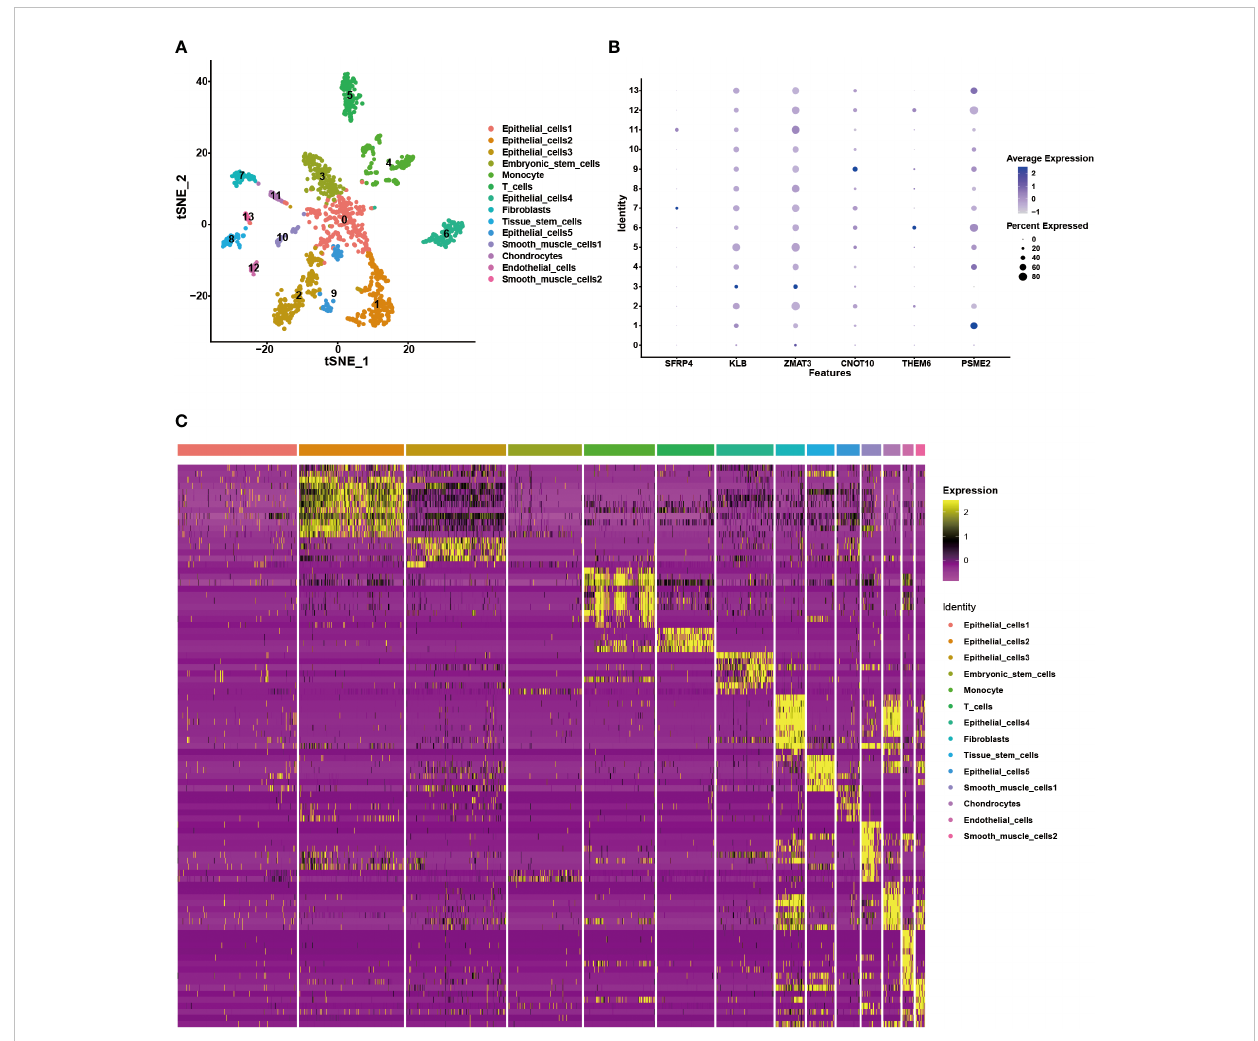
FIGURE 11 Validation of the gene signature in the scRNA-seq data. (A) The tSNE analysis showing 14 cellular subtypes in the scRNA-seq data. (B) The heatmap demonstrating the corresponding genes in each cellular subtype. (C) The expression level of the model genes in each cellular